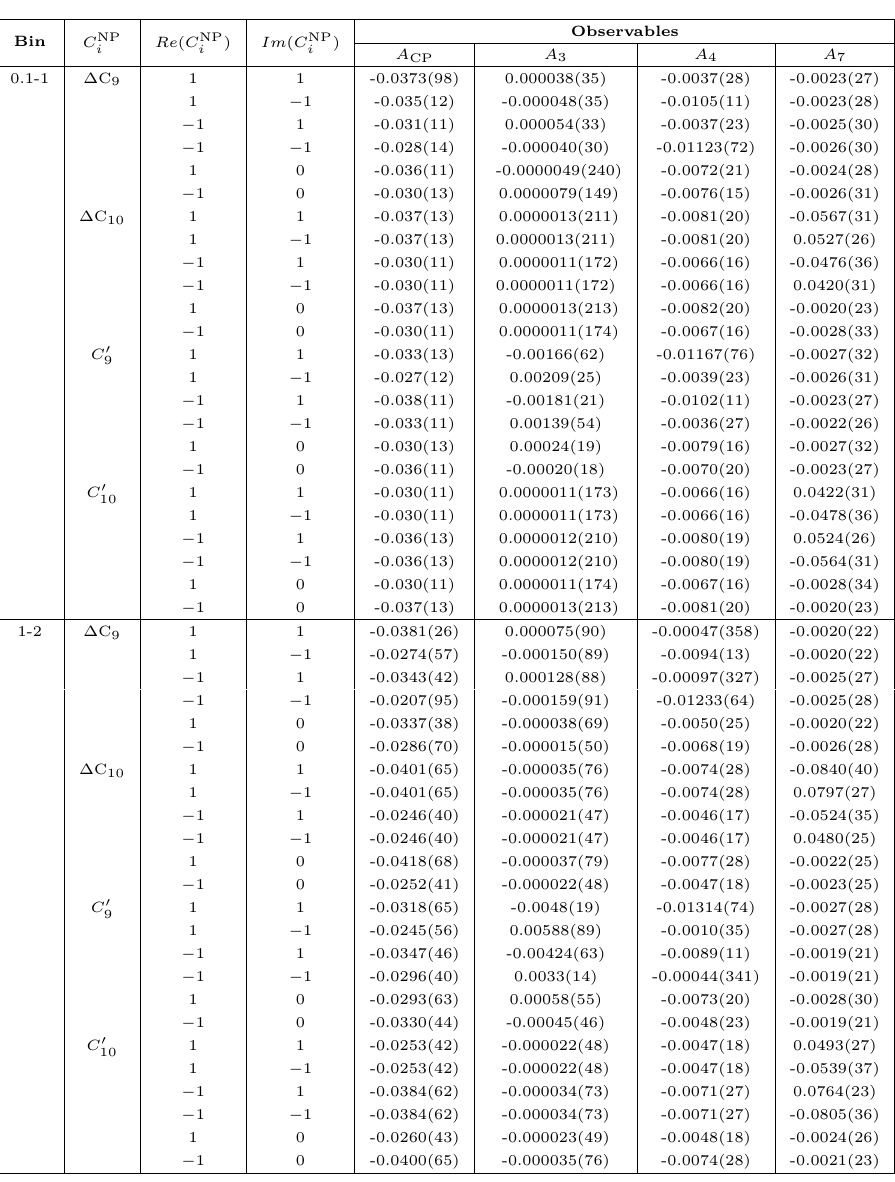
¯ B 0 ( B 0 ) → ρ 0 ll which and C 0 9 , 10 9 , 10